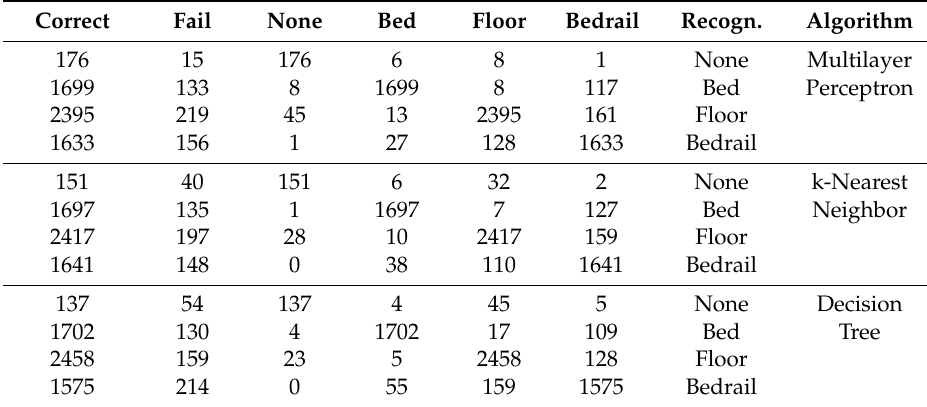
Table 5. Confusion matrix of location classification by